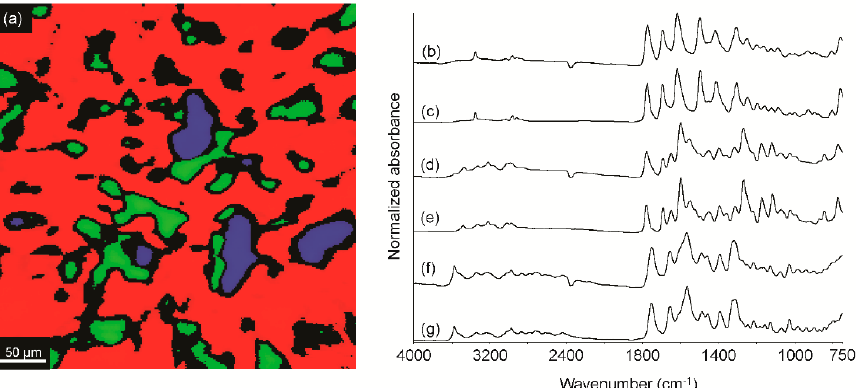
Figure 2. ATR-FT-IR image of the suspect product ( a ); and representative spectra from the blue ( b ); green ( d ) and red ( f ) regions compared to pure compound reference spectra of penicillin G sodium salt ( c ); penicillin G procaine salt hydrate ( e ) and penicillin G benzathine salt ( g ).